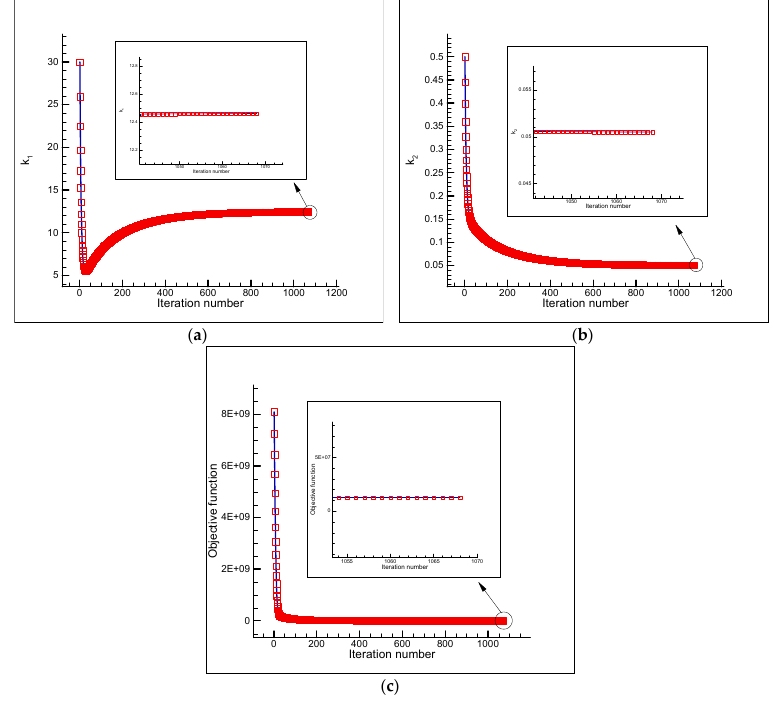
Figure 16. Estimation of k 1 ( a ) and k 2 ( b ), and the objective function versus iteration number ( c ) using = 30.0 + 0.5 T ( W ) and a single sensor placed at the node ( i , j ) = ( 3,12 ) by the initial guess k T m. ◦ C initial 1 considering the measurement error of σ =